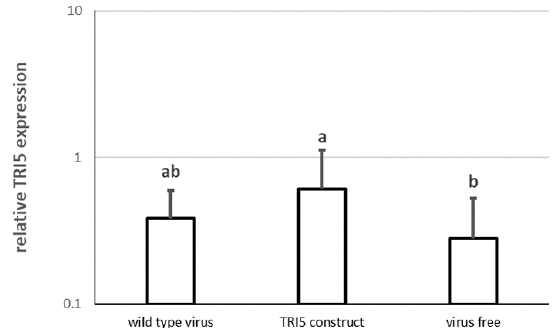
Figure 4. Expression of the TRI5 gene in F. culmorum growing on plants infected with different viral constructs. Expression is presented relative to the control sample, using EF1A as a reference gene. The graph shows the means and standard deviations of seventeen plant heads for the TRI5 construct, nine plant heads for the wild-type virus and fourteen plant heads for the virus-free variant. Virus free plants were mock inoculated with water, wild type virus plants with BSMV RNAs α + β + γ , and TRI5 plants with BSMV RNAs α + β + γ -TRI5; for more details see Section 2.7. Letters above the columns indicate statistical significance; p -value ≤